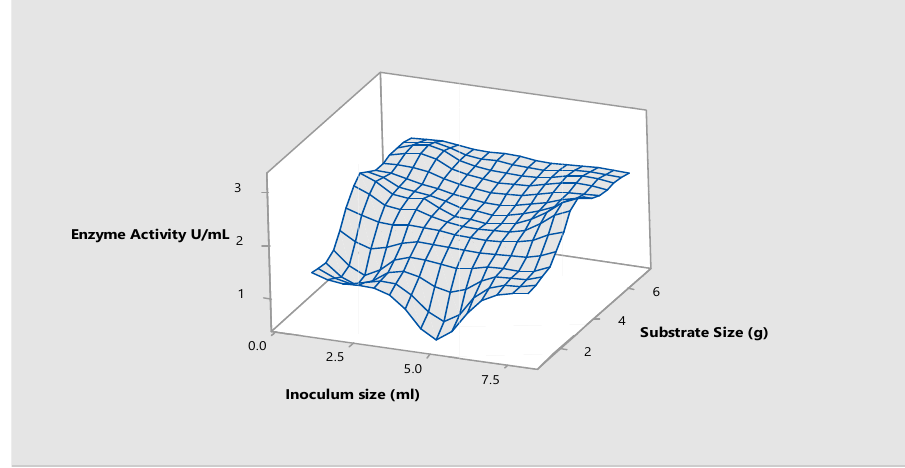
Figure 5. Surface plot of Enzyme Activity (U/mL) vs. Substrate Size and Inoculum Size.